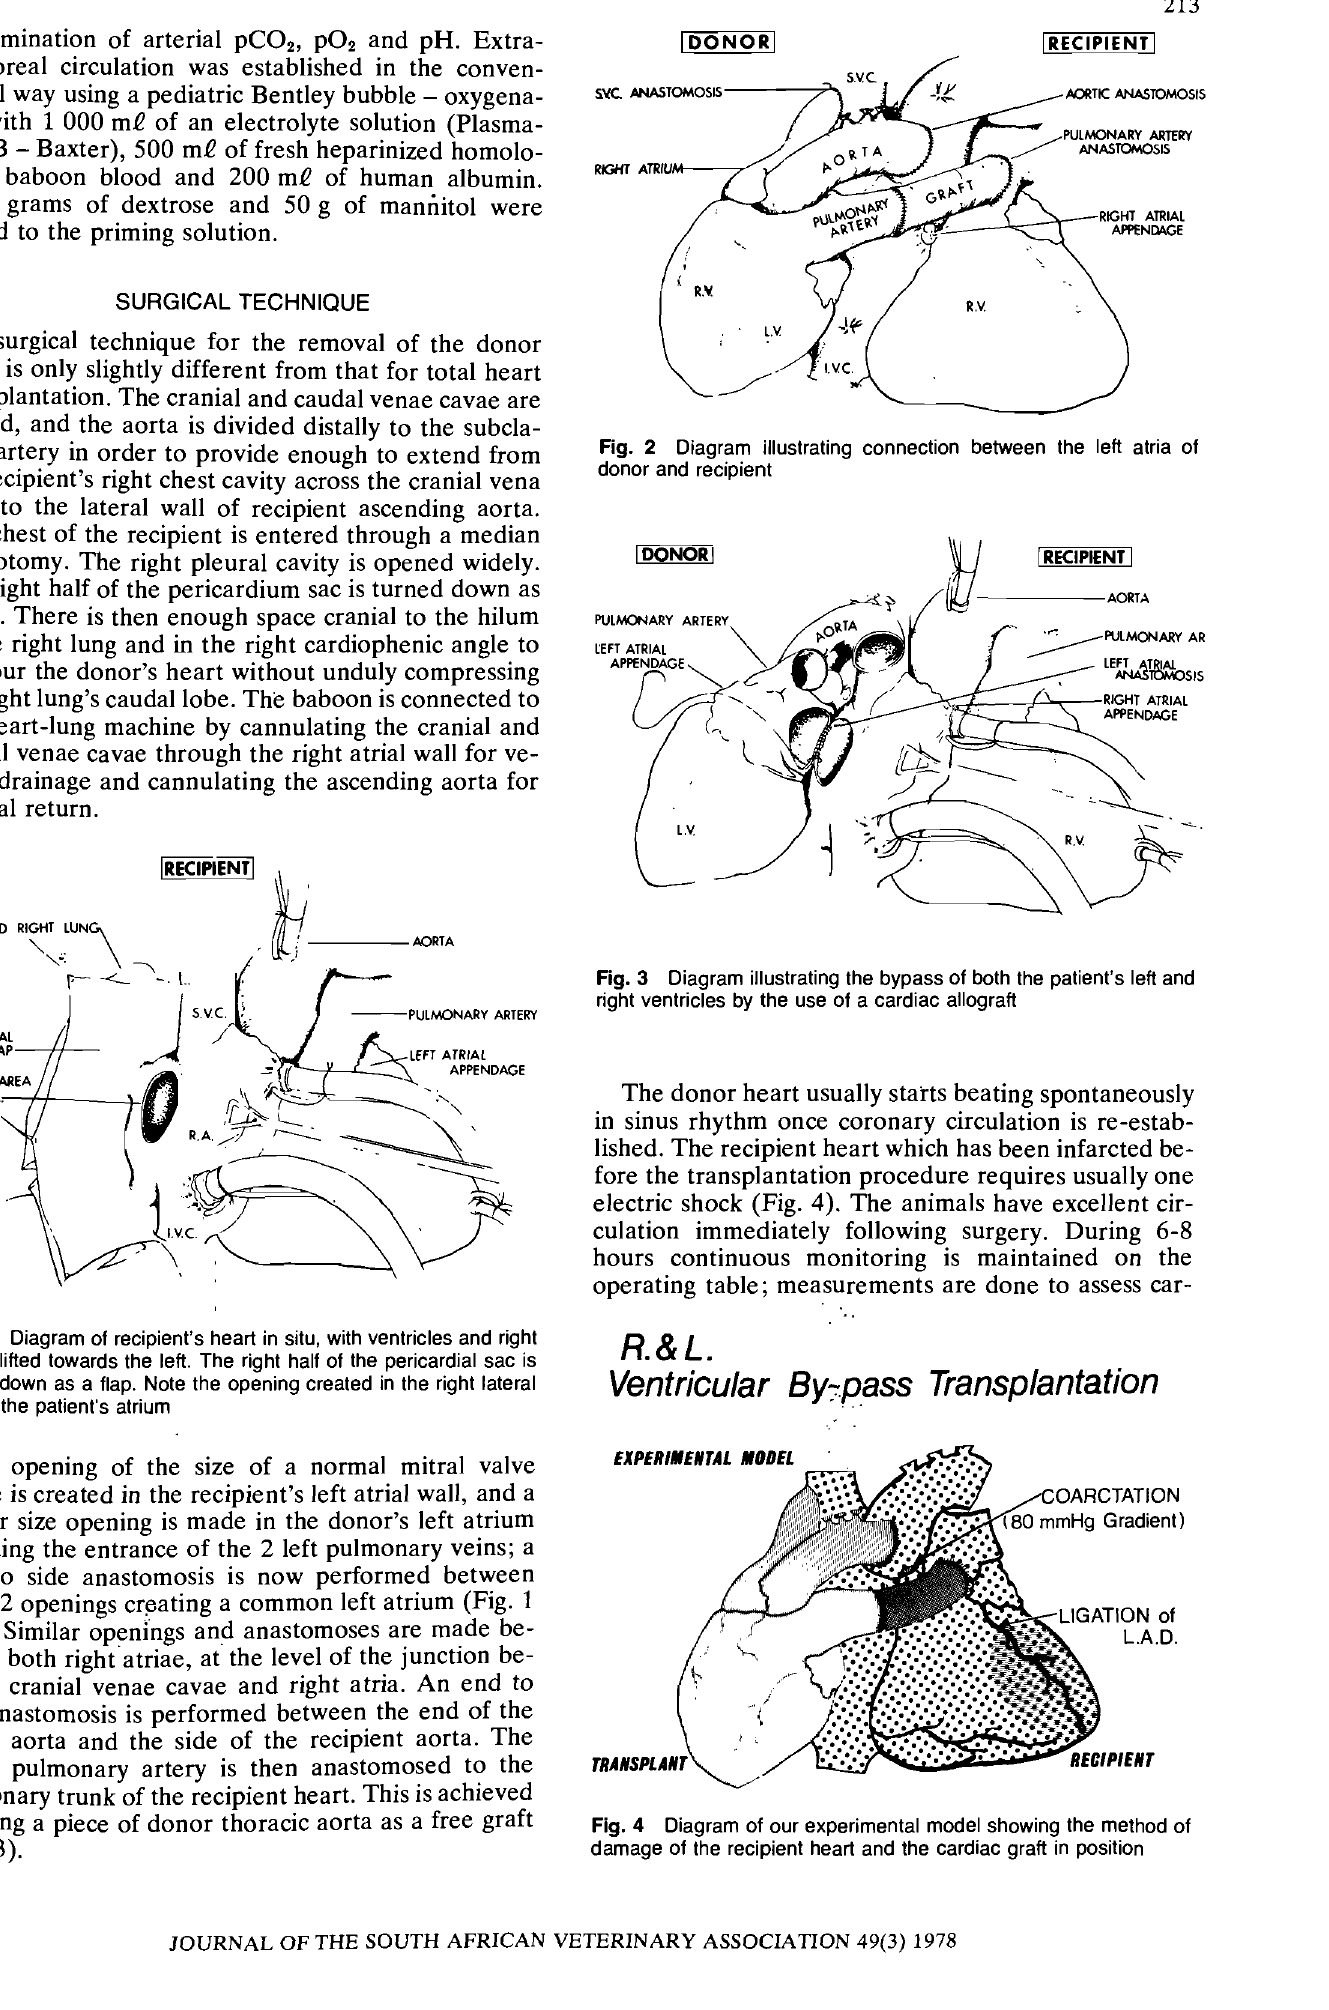
JOURNAL OF THE SOUTH AFRICAN VETERINARY ASSOCIATION 49(3)